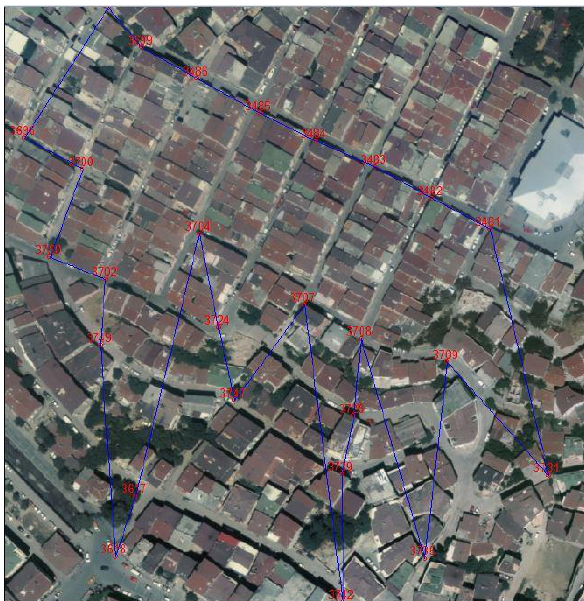
Figure 2. Aerial orthophoto test point representation Point I.D.